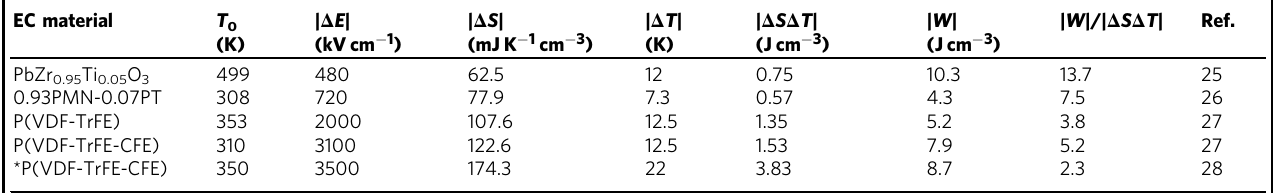
Table 1 Recoverable work and cycle work for giant EC materials EC material